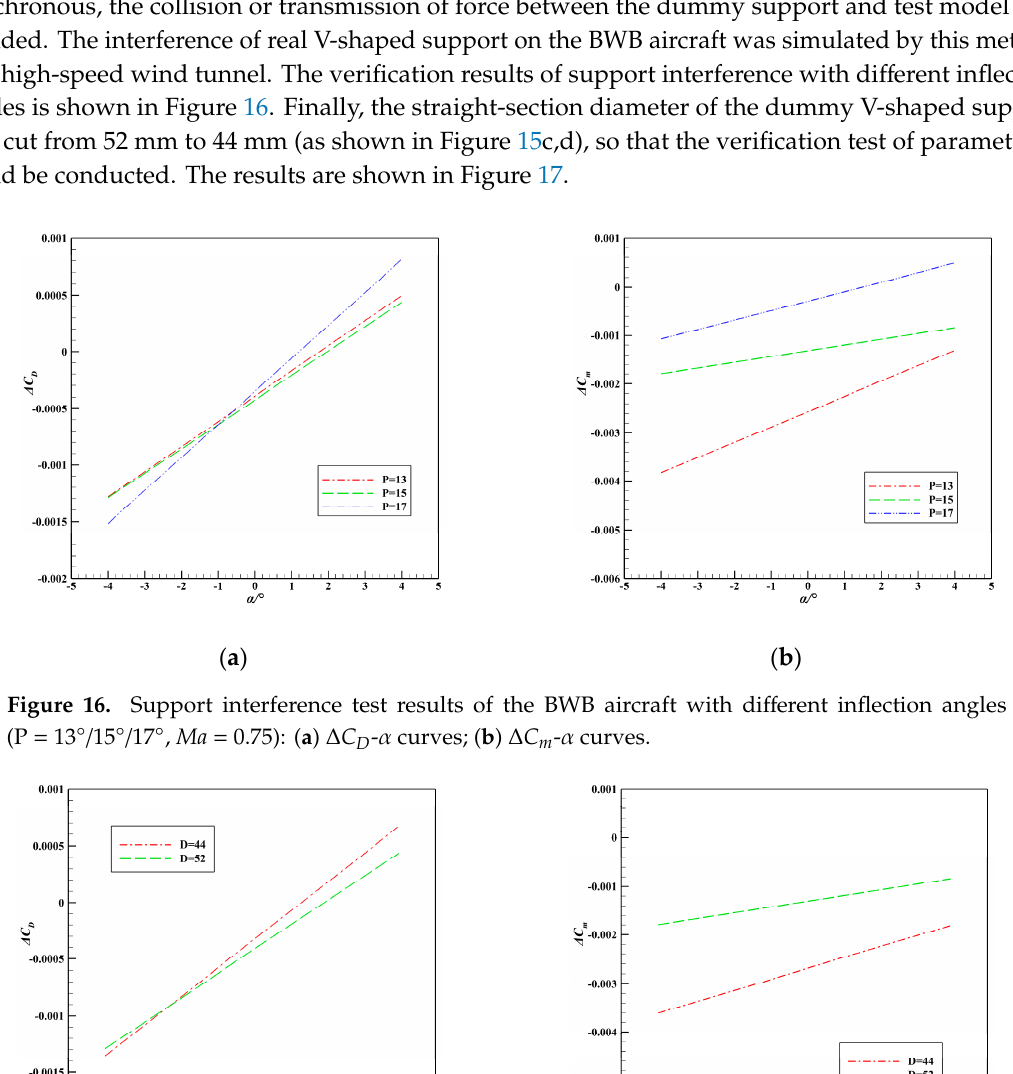
Figure 15. Verification test equipment of the dummy V-shaped support with different inflection angles (P = 13°/15°/17°) and different straight-section diameters (D = 52 mm/44 mm): ( a ) dummy V- shaped supports with different inflection angles; ( b ) verification equipment in the wind tunnel; (c) straight section of the dummy V-shaped support with D = 52 mm, before the mechanical cutting; (d) straight section of dummy V-shaped support with D = 44 mm, after the mechanical cutting.